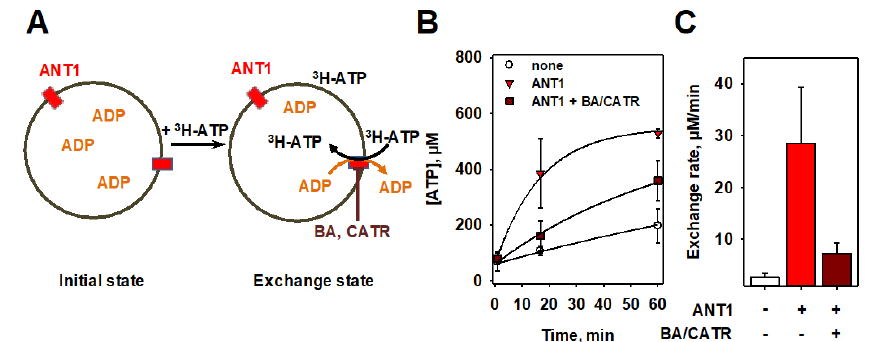
Figure 3. ADP/ATP exchange rate measurements of ANT1 using a radioactive assay. ( A ) Scheme of the 3 H-ATP uptake assay. ( B ) Time course of the ATP concentration inside (proteo-)liposomes as determined by 3 H-ATP uptake assay in the presence of ANT1 (triangles), ANT1 plus bongkrekic acid (BA) and carboxyatractyloside (CATR, squares), and in the absence of protein (circles). Lines are fits of an exponential rise to maximum function to the data. ( C ) Values of the ADP/ATP exchange rate as determined from the fit parameters in ( B ). In all measurements, the buffer contained 50 mM Na 2 SO 4 , 10 mM Tris, 10 mM MES, and 0.6 mM EGTA at pH = 7.34 and T = 297 K. Lipid membranes were made of 45:45:10 mol% of DOPC, DOPE and CL, respectively. The lipid concentration was 1.0 mg/mL and the liposome diameter was approximately 100 nm. The concentration of ANT1 was 8.67 µg/mL and the concentrations of ATP, ADP, BA and CATR were 2 mM, 2 mM, 100 µM and 100 µM, respectively. Data are shown as the mean ± SD of at least three independent measurements.